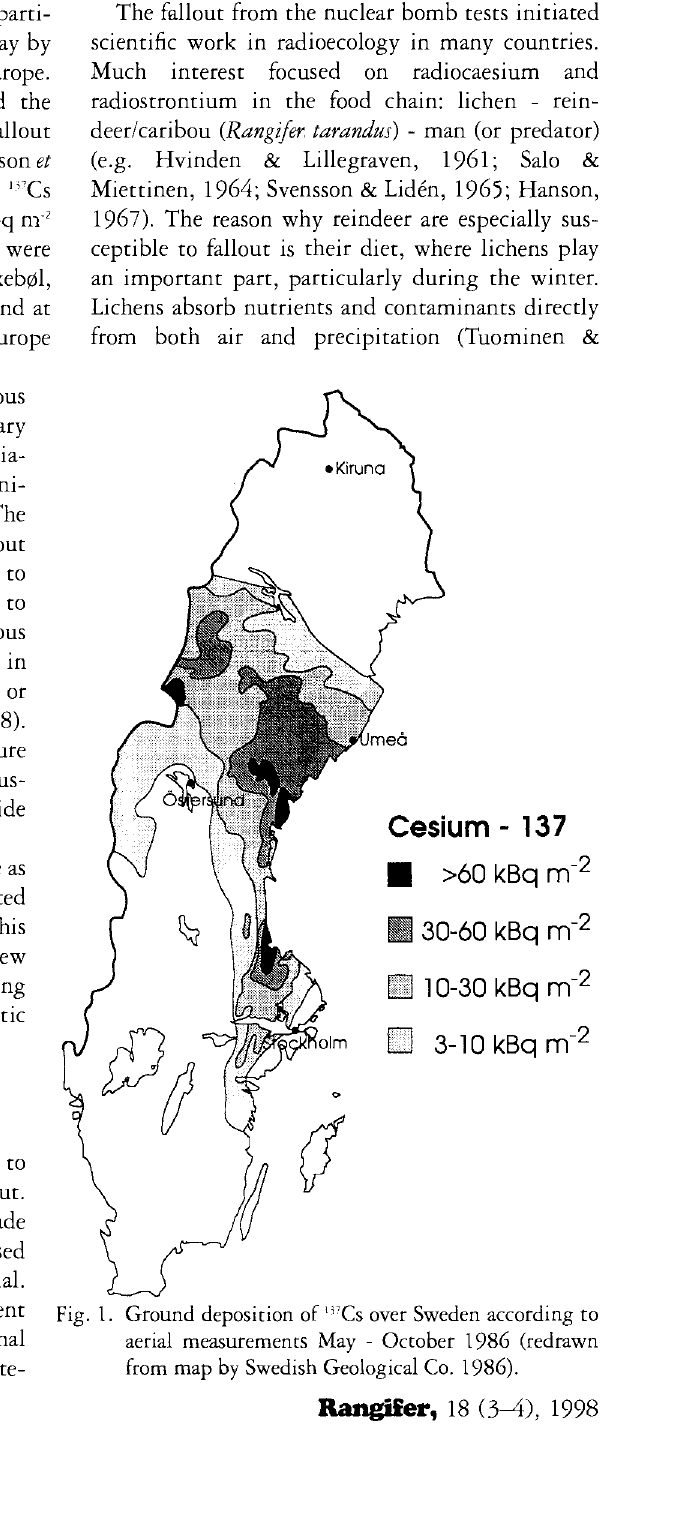
Fig. 1. Ground deposition of 15 Cs ovet Sweden according to aerial measurements May - October 1986 (redrawn from map by Swedish Geological Co.